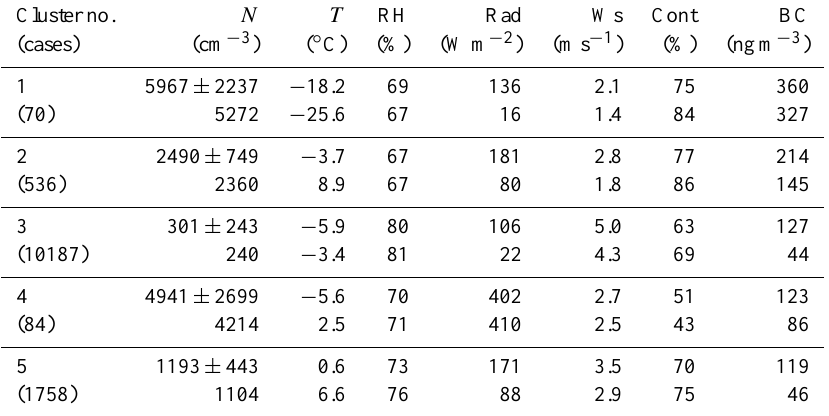
Table 2. Total particle number concentration ( N ), temperature ( T ), RH, solar radiation (Rad), wind speed (Ws), percentage over continental areas (Cont), and black carbon mass concentration (uncorrected) (BC) for different size distribution clusters (numbers 1–5, referring to Fig. 5a). Number of cases available for each cluster is shown in parenthesis below the cluster number. For different variables, both the average (upper row) and median (lower row) are calculated, and for total number the standard deviation is also presented. Cluster no. N T RH Rad Ws Cont BC (cases) (cm − 3 ) ( ◦ C) (%) (Wm − 2